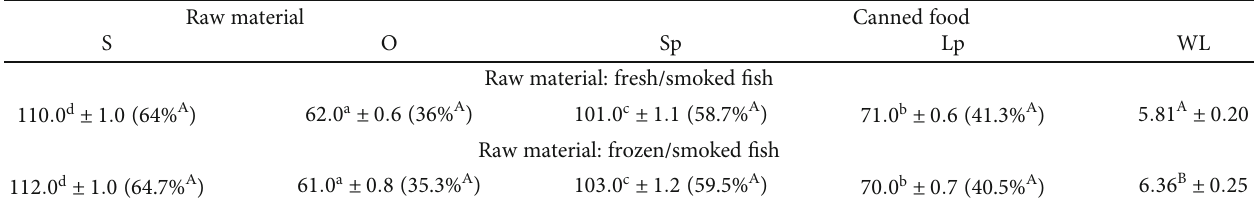
Table 1: The weight (g) of the smoked fi sh, oil, and solid and liquid parts from canned fi sh in the unit package. Raw material Canned food S O Sp Raw material: fresh/smoked fi